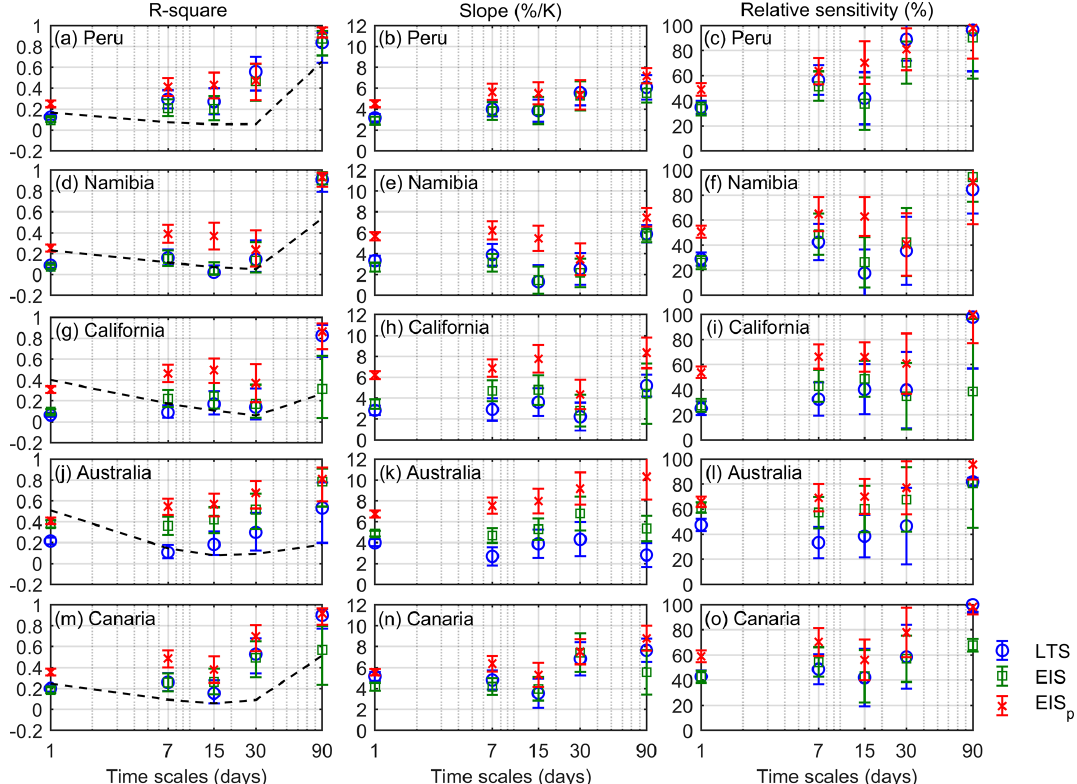
Figure 10. R square (left panel), slope (middle panel) and relative sensitivity (right panel) of the GEO-MODIS LCC to the ERA5-based 10 ◦ × 10 ◦ regional mean LTS (blue cycle), EIS (green square) and EIS p (red cross) through daily to seasonal timescales over the five typical eastern oceans defined in Klein and Hartmann (1993). The error bars show the 95% confidence interval based on the t test. The dashed black lines in the left panel are the fraction of the LCC variance on different timescales divided by the total variance.